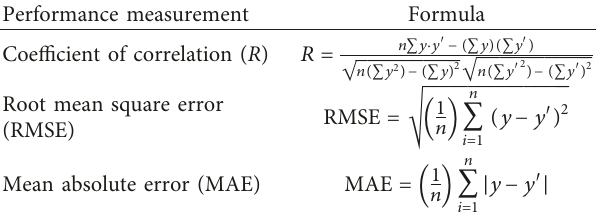
Table 1: Performance measurement for training dataset and testing